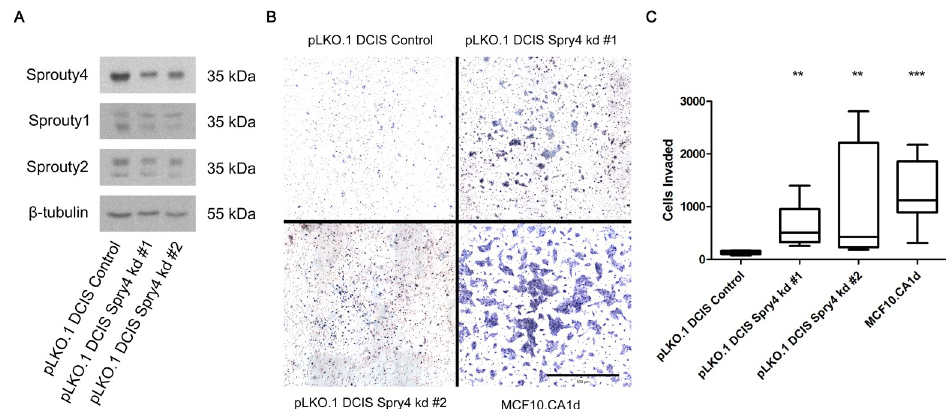
Fig 11. Stable knockdown of Sprouty4 in MCF10.DCIS cells promotes invasion. (A) MCF10.DCIS cells were infected with lentivirus containing either vector control or Sprouty4-targeting shRNA constructs. Membranes were immunoblotted for Sprouty4, Sprouty1, Sprouty2, and β -tubulin. (B) pLKO.1 DCIS control, pLKO.1 DCIS Sprouty4 knockdown, and MCF10.CA1d cells were then serum-starved overnight and allowed to invade though 1.5 mg/mL of matrix for 24 hours via Boyden chamber assay. Representative images of cellular invasion (scale bar = 500 μ m). (C) Invasion was quantified and plotted using GraphPad Prism. A Kruskal-Wallis test employing Dunn’s test of multiple comparisons showed significant differences in invasion when comparing Sprouty4 knockdown or MCF10.CA1d cell lines to control ( α = 0.01, 99% CI; �� p < 0.01, ��� p < 0.001). Whiskers represent the minimum and maximum values and bars represent the median. Data were collected from three independent